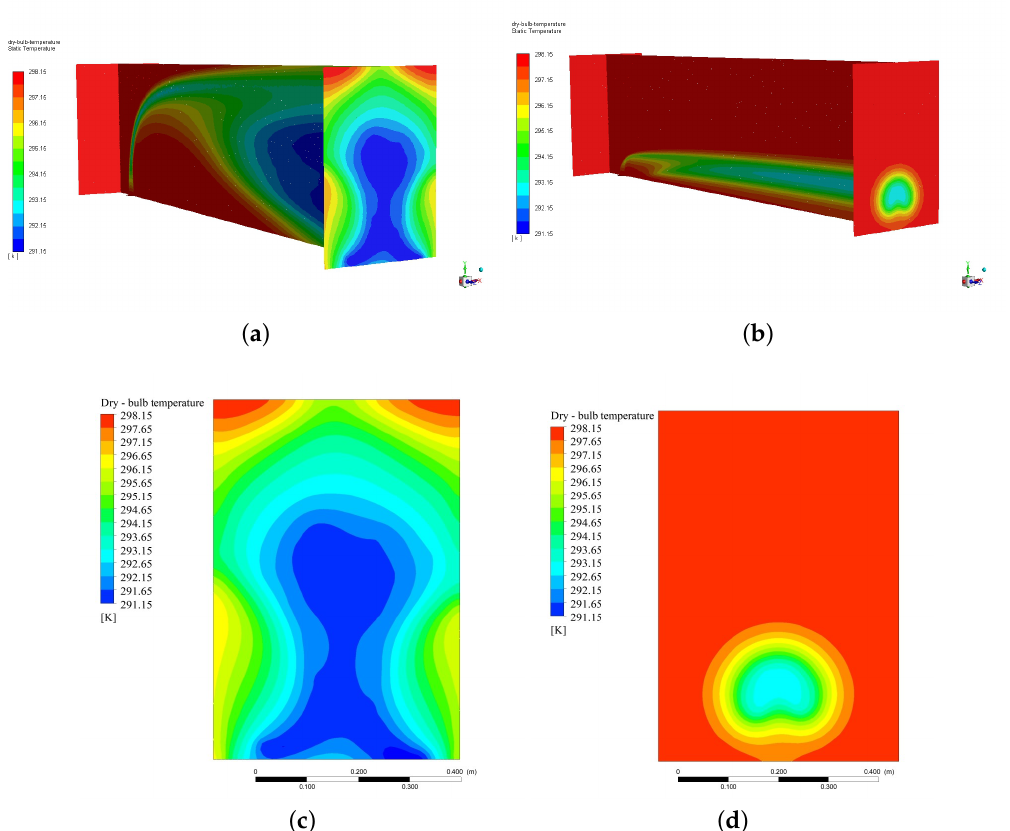
Figure 11. Temperature contours in the axial mid plane and the outlet section of the domain: ( a , c ) v T = 0.5 m s − 1 , v i = 3.5 m s − 1 and ˙ m w = 5 × 10 − 5 kg s − 1 ; and ( b , d ) v T = 2.5 m s − 1 , v i = 4 m s − 1 and ˙ m w = 4 × 10 − 4 kg s − 1 .